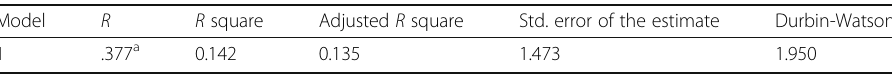
Table 10 Model summary — marketing strategy